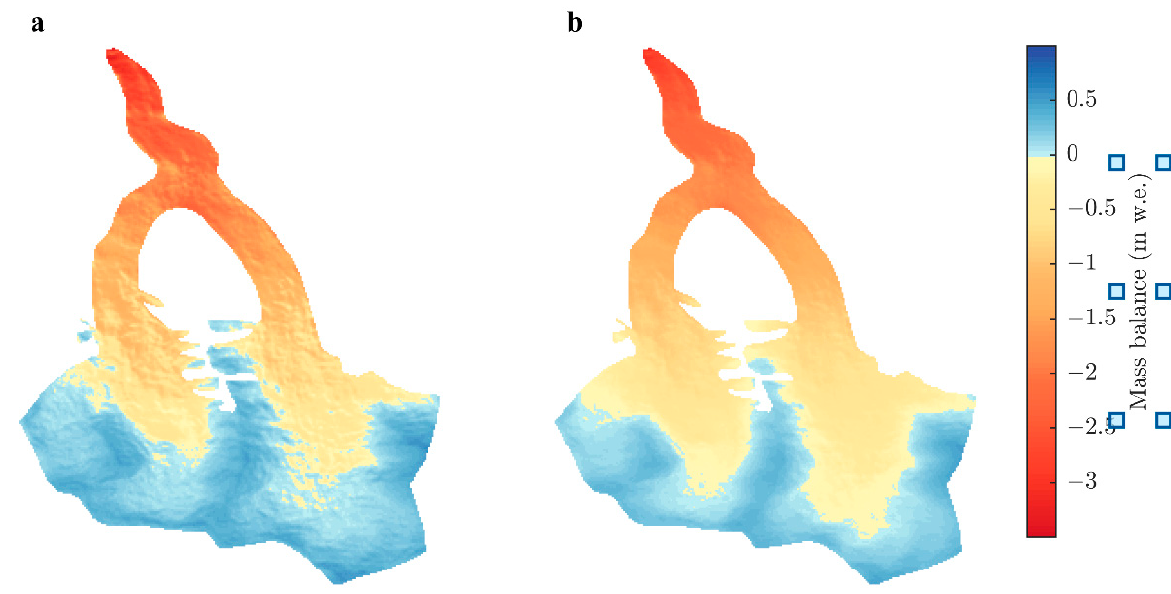
Figure 11. The multi-year average annual MB of LHG12 modeled by SEBM ( a ) and ETIM ( b ).